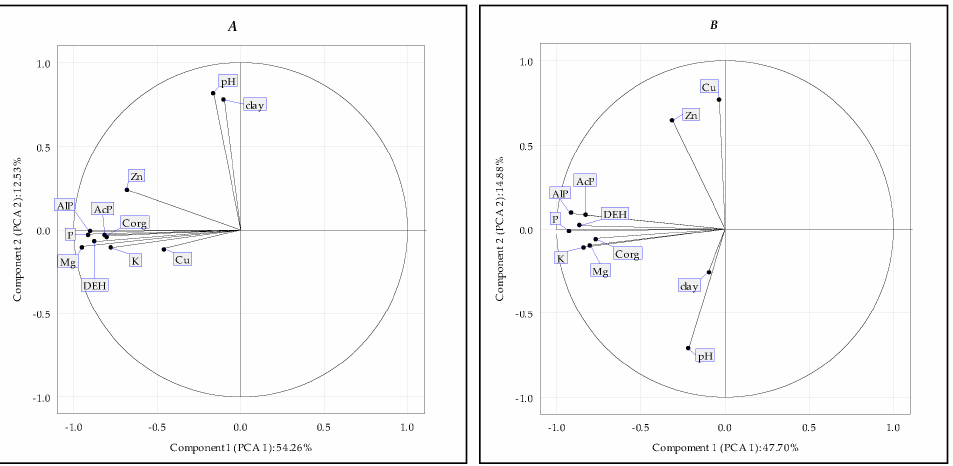
Figure 7. ( A , B ). Configuration of variables in the system of the first two axes PC1 and PC2 of principal components in the soil after application distillery stillage A (2019 year) and B (2020